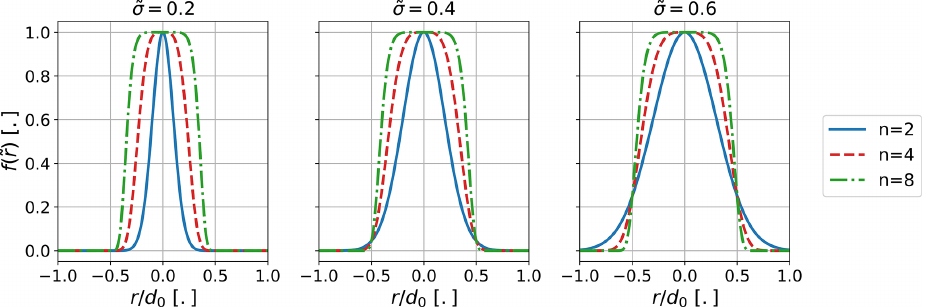
Figure 1. Super-Gaussian profiles of orders n = 2 to n = 8 for three different characteristic wake width values.